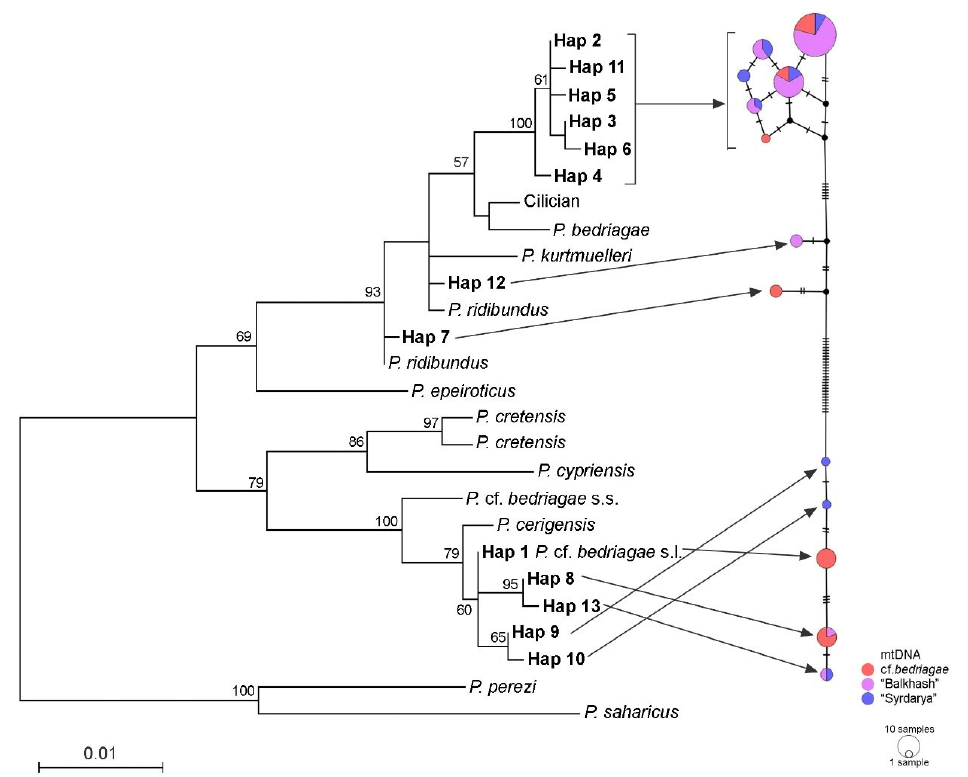
Figure 4. ML tree based on SAI sequences. Bootstrap supports lower than 50% are not shown on the tree. Median-joining haplotype network based on SAI of nDNA.